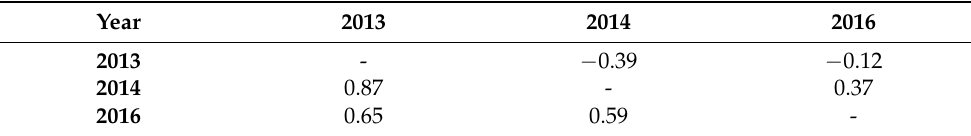
Figure 5. Distribution maps based on random forest regression of overall meiofauna abundance ( a – c ) and Simpson’s Index of diversity at a high taxonomic level ( d – f ) based only on response data obtained in 2013, 2014 and 2016 using backscatter, bathymetry, sediment and nodule parameters as predictor variables. Table 6. Pairwise Pearson’s correlation between spatial prediction of overall meiofauna abundance (upper, right-hand triangle) and meiofauna diversity on high taxonomic level (Simpson’s Index) (lower, left-hand triangle) including only response variables obtained in one year; all values are highly